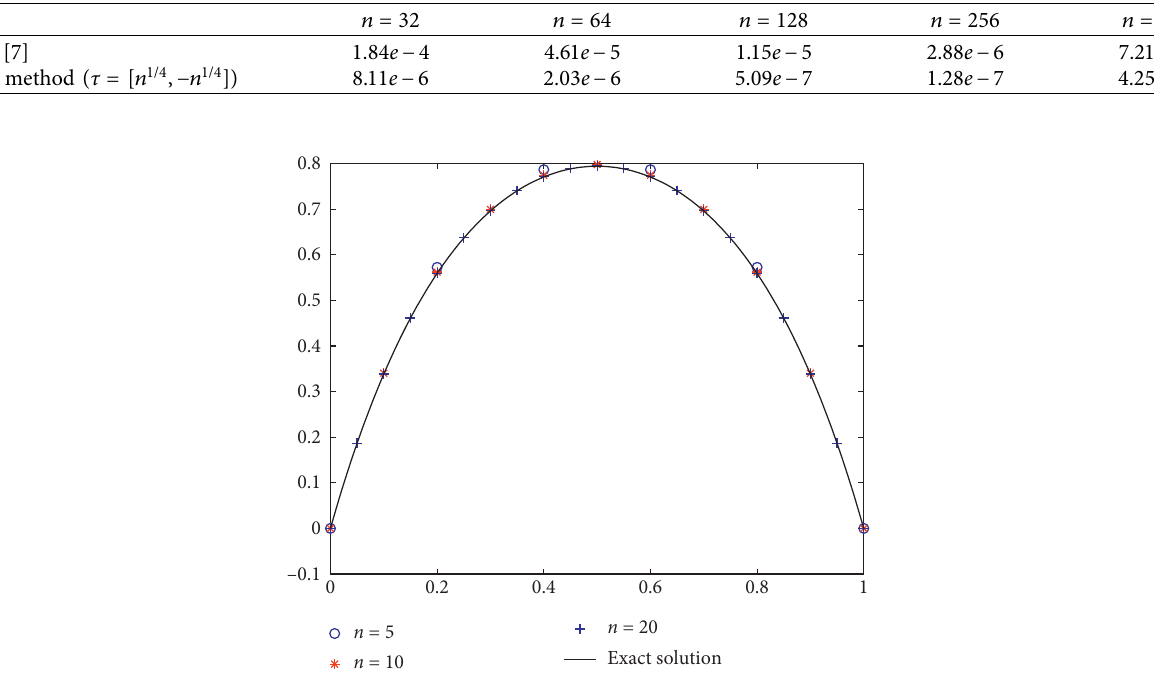
Figure 2: Results of the boundary value problem (72) for ε � 0 . 1, and n � 5 , 10, and 20, respectively. Table 2: The maximum error ‖ E ‖ and root mean square error for problem (74). ∞